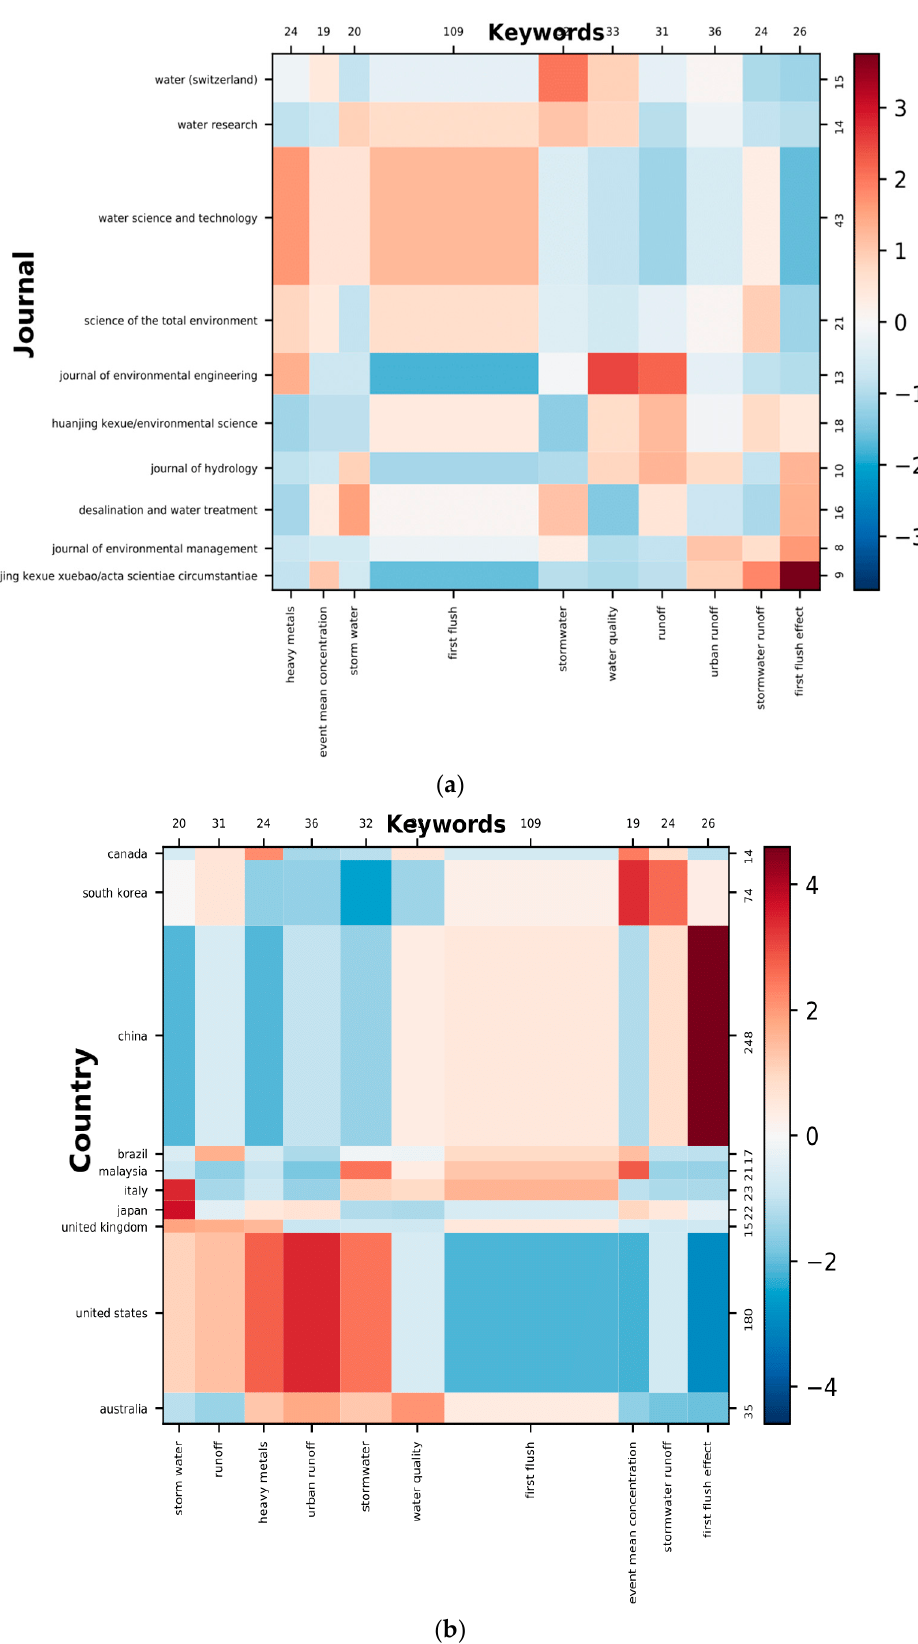
Figure 2. Contingency matrix showing the relationship of ( a ) keywords and journal; and ( b ) keywords and country.